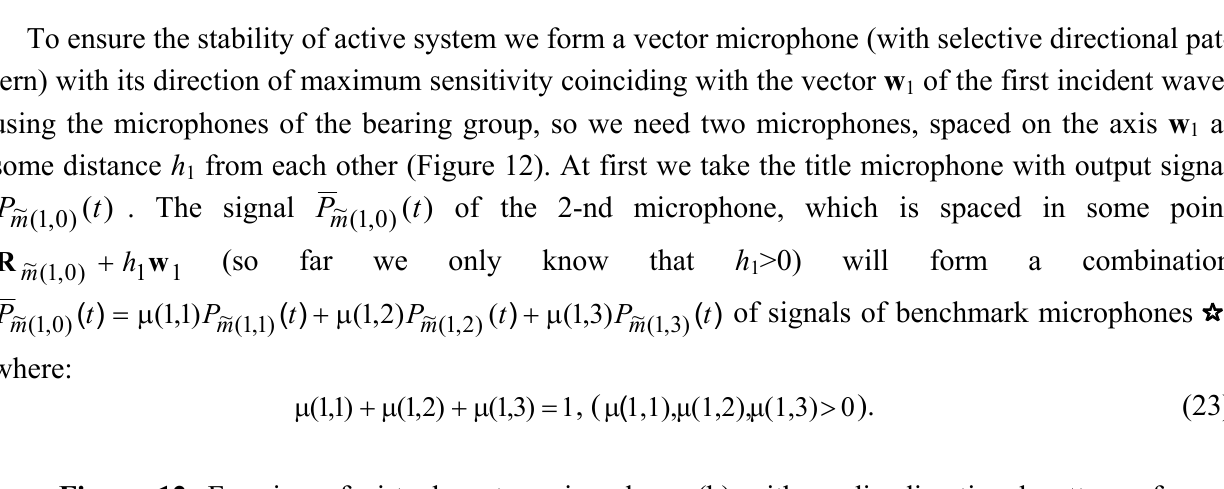
Figure 12. Forming of virtual vector microphone (b) with cardio directional pattern of sensitivity by means the combination (a) of signals of microphones group of bearing of the i -th incident wave. The mass center of points direction of the vector w i